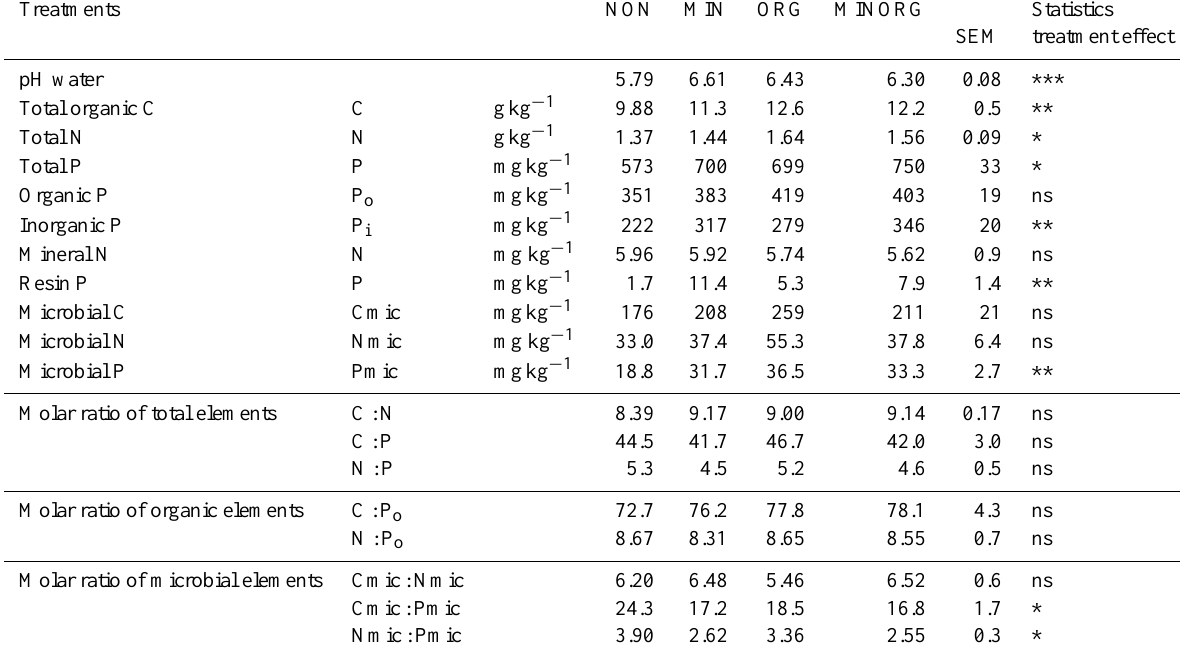
Table 7. Effects of treatments on selected soil properties of the 0–20cm horizon and on C:N:P ratios in the fourth crop rotation in the DOK field experiment, Switzerland. The soil pH, total C, and total N are from Oberson et al. (2013); the other data are